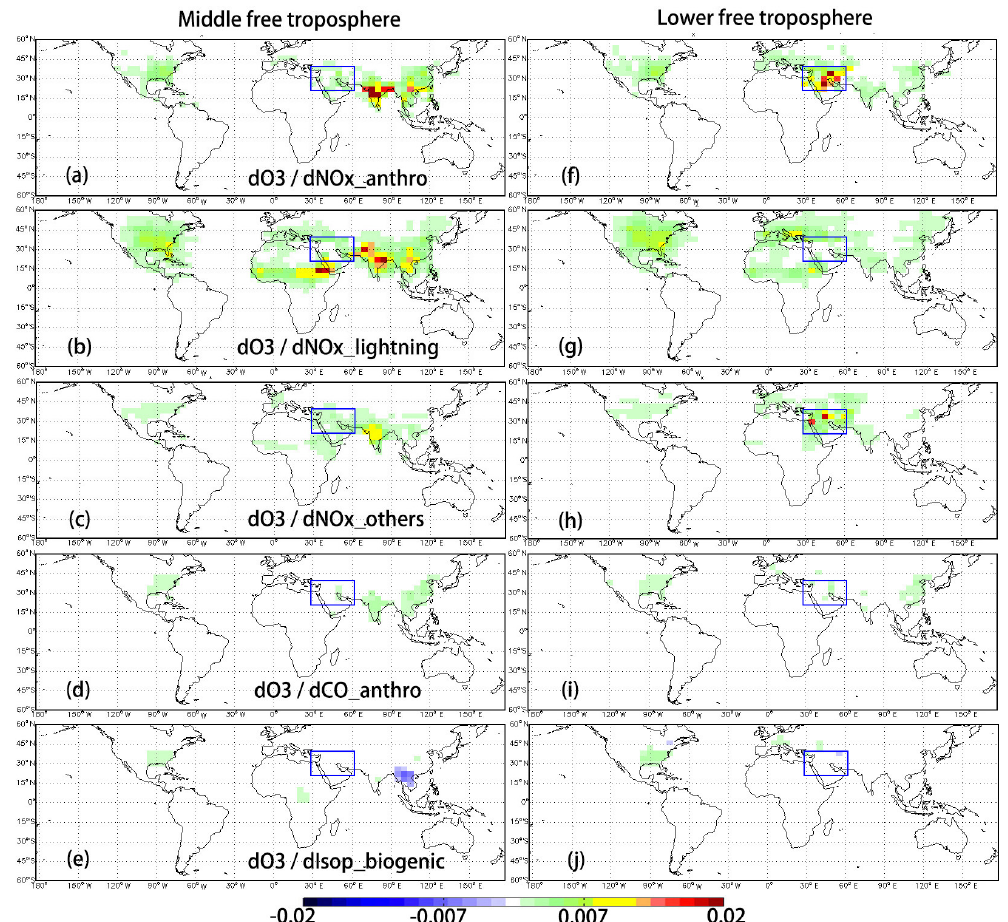
Figure 4. Response of middle free tropospheric (450–350hPa) and lower free tropospheric (700–600hPa) O 3 over Middle Eastern Asia (blue box) to precursor emission perturbation from anthropogenic NO x , lightning NO x , other NO x sources (biomass burning, biofuel and soil NO x ), anthropogenic CO and biogenic isoprene, for June–August 2005. The response can be explained as the mean change (unit of ppbv) of regional mean O 3 due to 10% increase of precursor emissions in a particular grid assuming unchanged chemical